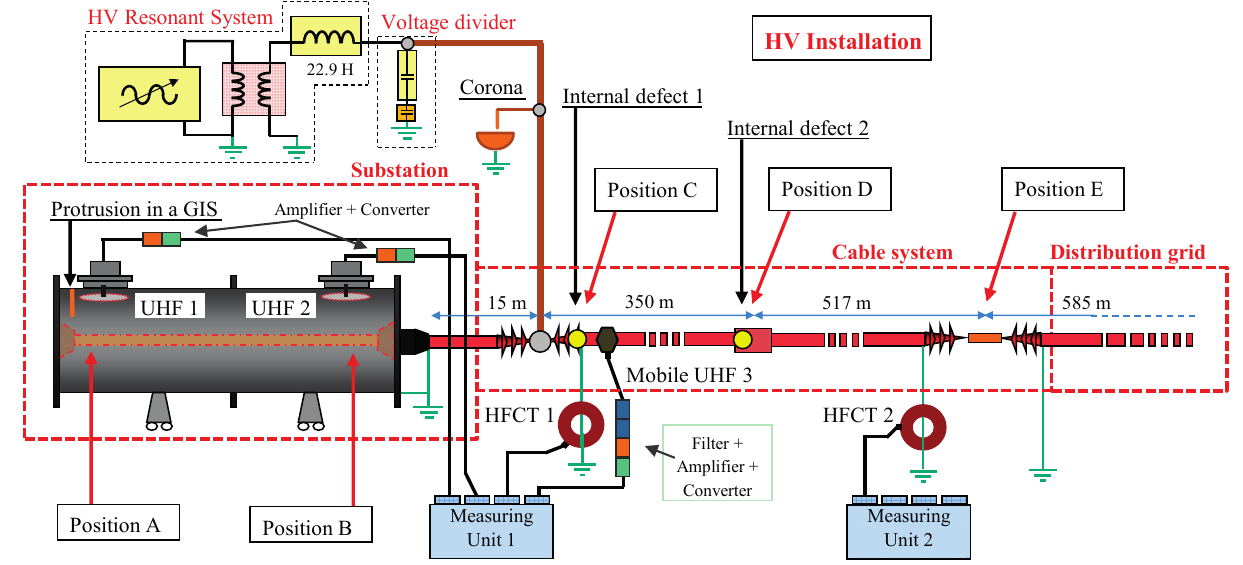
Figure 18. Experimental setup for the measurement of insulation defects with HF and UHF sensors.